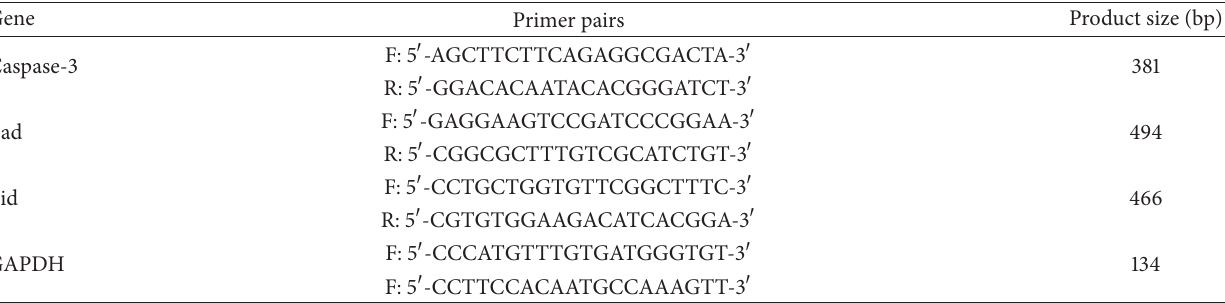
Table 1: Primer pairs for